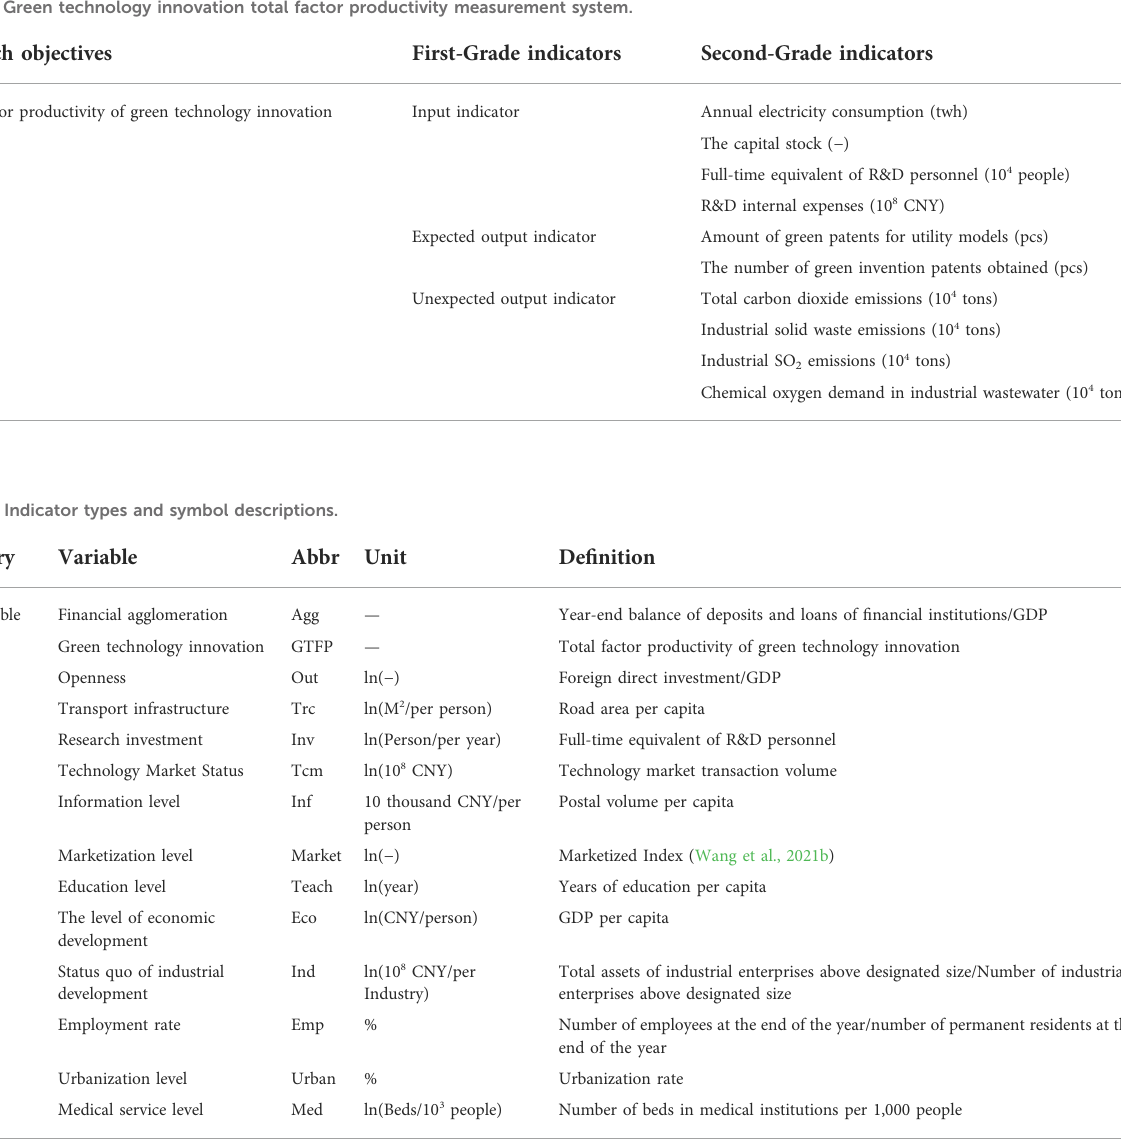
TABLE 1 Green technology innovation total factor productivity measurement system.